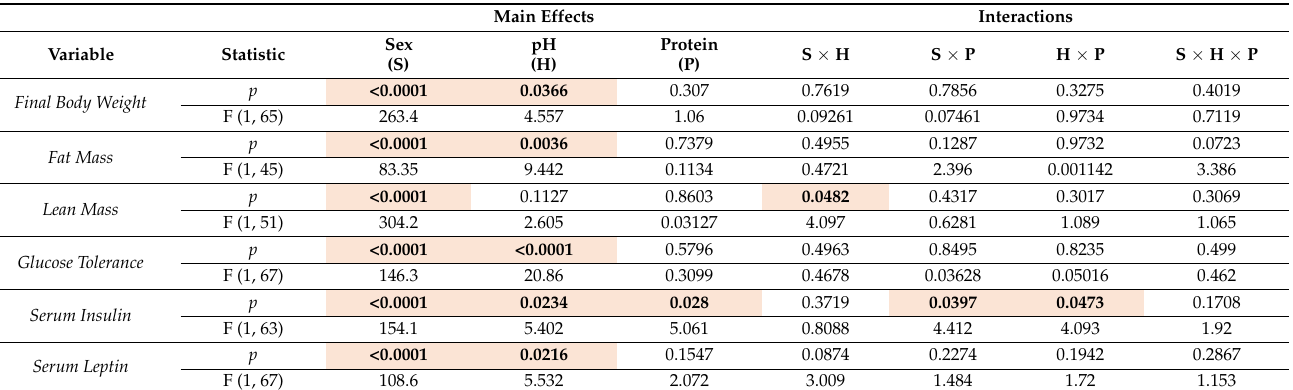
Table 4. Effects of sex, pH, and protein on body weight and body composition, glucose tolerance and serum markers in high fat (HF) diet-fed B6 mice. p and F values of three-way ANOVA to evaluate main effect and